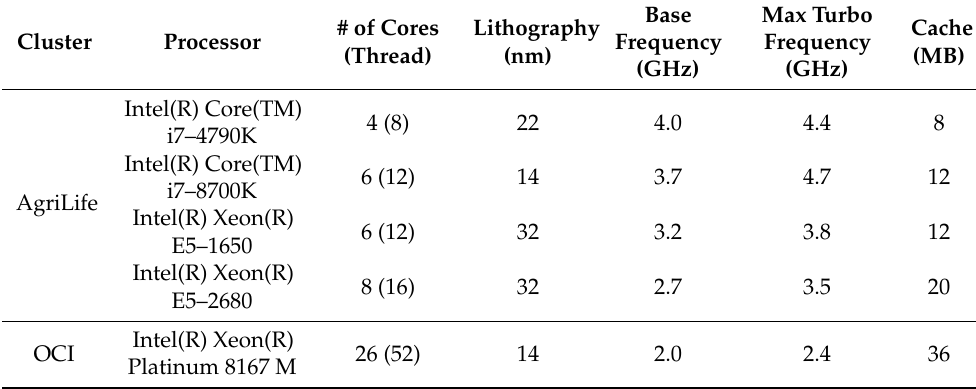
Table A1. Specifications of CPU of the nodes in the AgriLife and OCI.